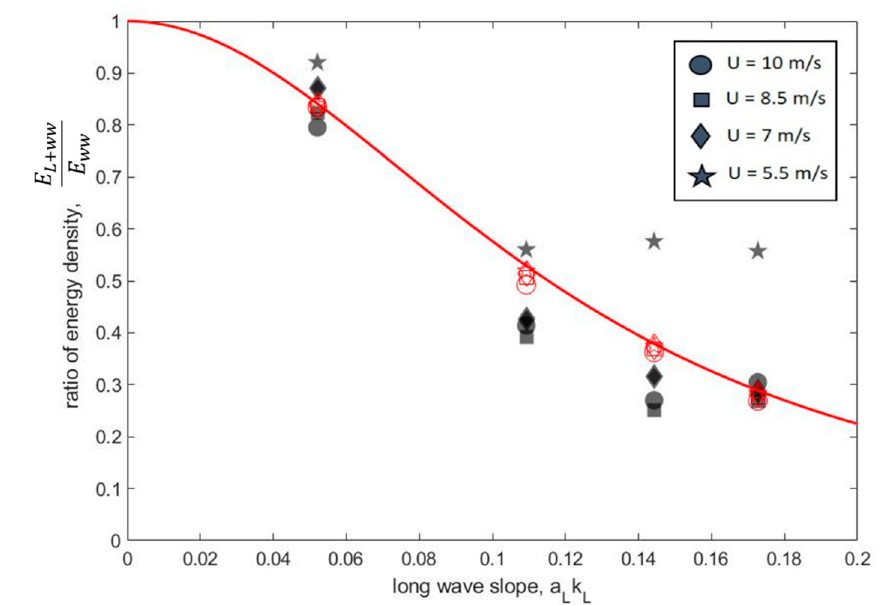
Figure 3. The Chen and Belcher model (CBM) model results for the experimental monochromatic wave data. The red, solid line represents the model results for α p = 100, using the simplification of τ t τ in Equation (19) and a range of a L k L ~ 0–0.2. Red, open symbols represent model results using τ t τ Equation (16) to calculate for the a L k L values of our long waves with no wind. The shape of the open symbols correspond to the same wind speeds as the closed symbols. Black, closed symbols represent results from laboratory data.